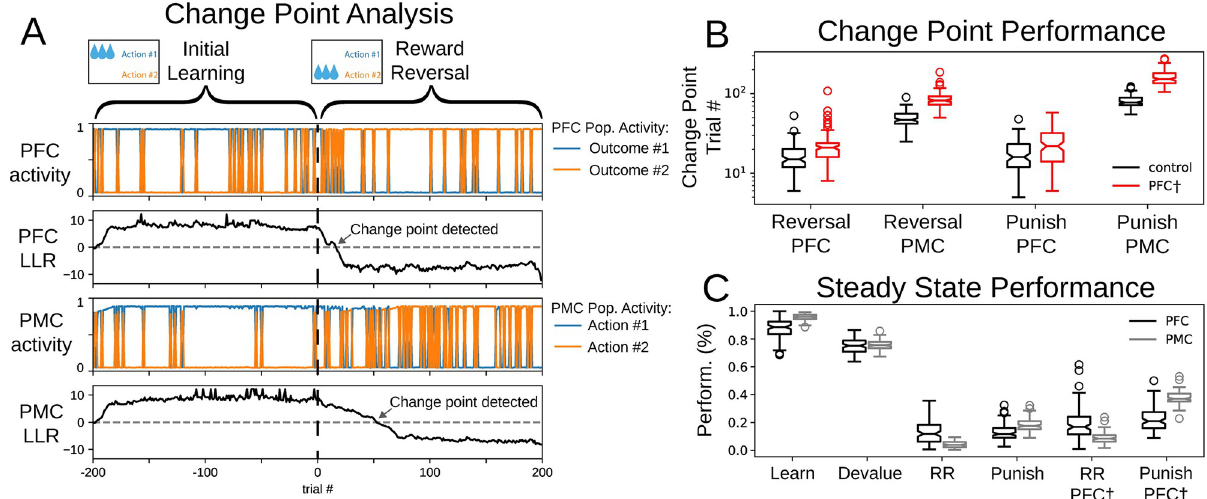
Fig 8. Analysis of model output across behavioral tasks. (A) Example model activity of an initial learning session and the following reward reversal session with change point analysis. Trial number here is relative to the beginning of the reward reversal session. (B) Change point analysis indicates the trial at which an ideal observer detects a change in cortical selection from action #1 to action #2. We compared change point performance in control simulations (black) and sessions with impaired PFC (red) (N = 100 agents). Box and whisker plots with median depicted. (C) Performance of agents at the end of each behavioral task showing the likelihood that agents select action #1). We compared PFC performance (black) to PMC performance (grey) (N = 100 agents). Box and whisker plots with median depicted.